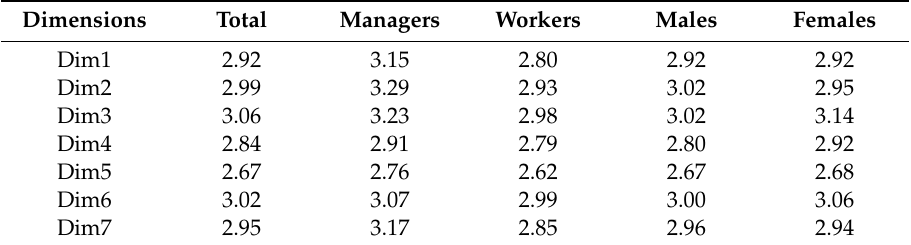
Table 4. Details of the scores of NOSACQ-50 divided per dimensions (mean values).